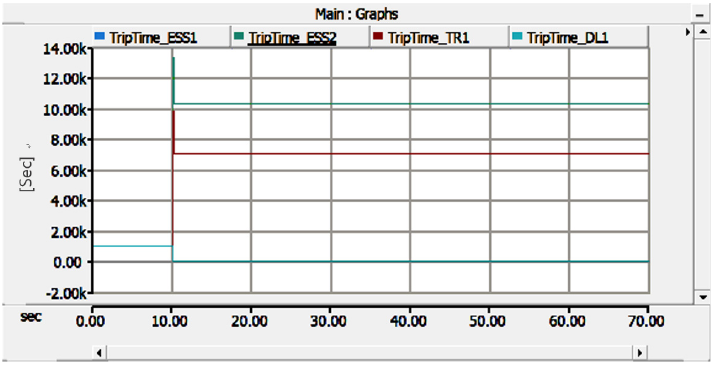
Figure 13. Relay trip time of case #2 using relay setting of case #1.